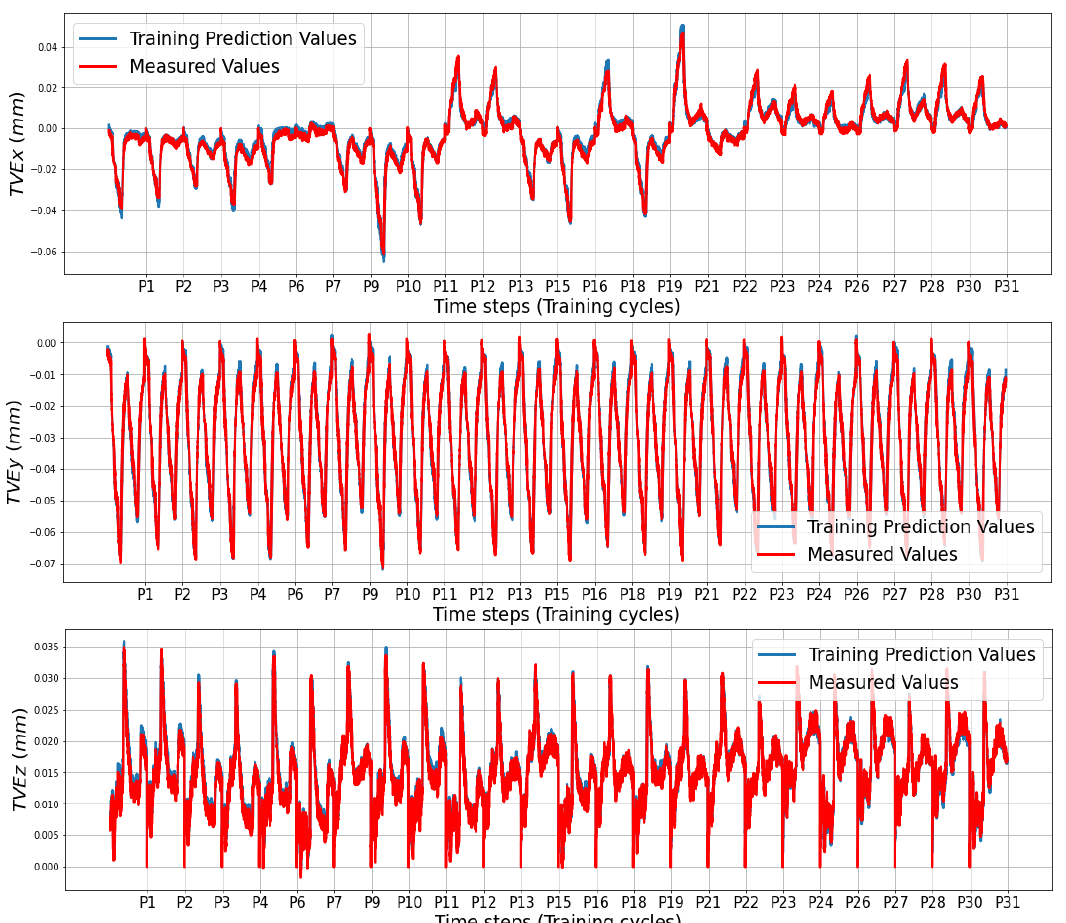
Figure 10. Training TVEx, TVEy, and TVEz from 24 positions in the long training process. For example, between P2 and P3 are the 528 cycle measured and predicted thermal volumetric errors at position P3 (1 cycle = 15 min).